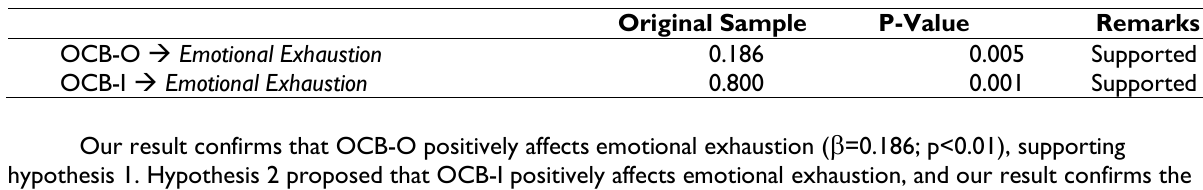
Table 4. Direct Effect Result